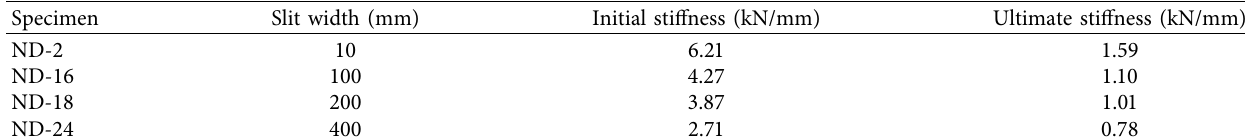
Table 6: Stiffness of different slit